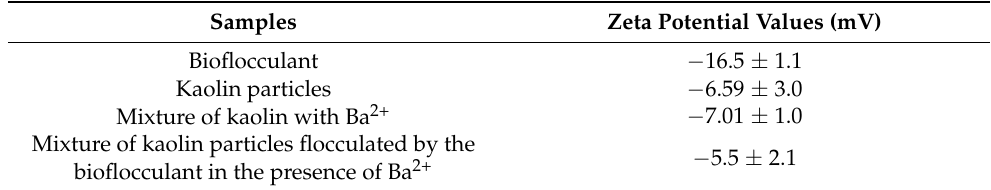
Table 4. Zeta potential of sample used to evaluate flocculation mechanisms of the bioflocculant.